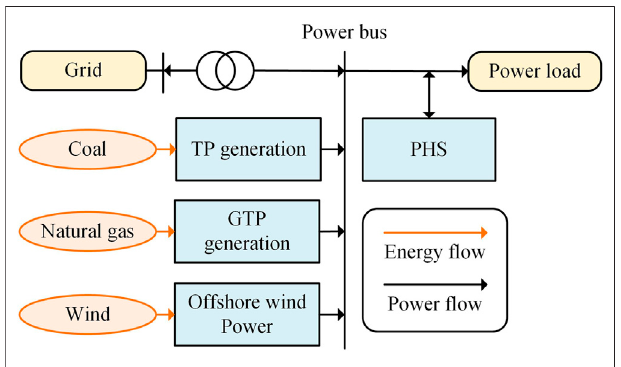
FIGURE 1 | Model of multi-source system integrated with